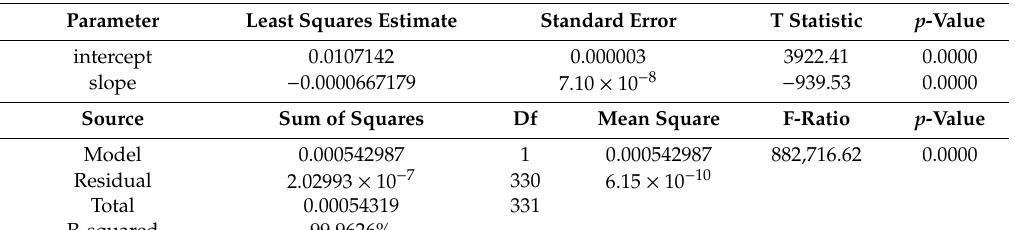
Table 3. Simple regression analysis results for drying rate DR as a function of time for sage